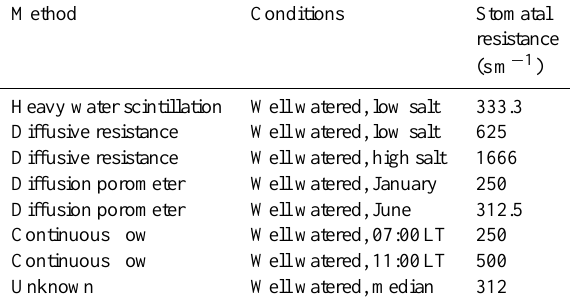
Table B1. Measurements of the stomatal resistances of Jojoba us- ing different methods, at different times of day; and under varying moisture and salinity conditions. Taken from the Seventh Interna- tional Conference on Jojoba and Its Uses: Proceedings (1988). See the text for individual